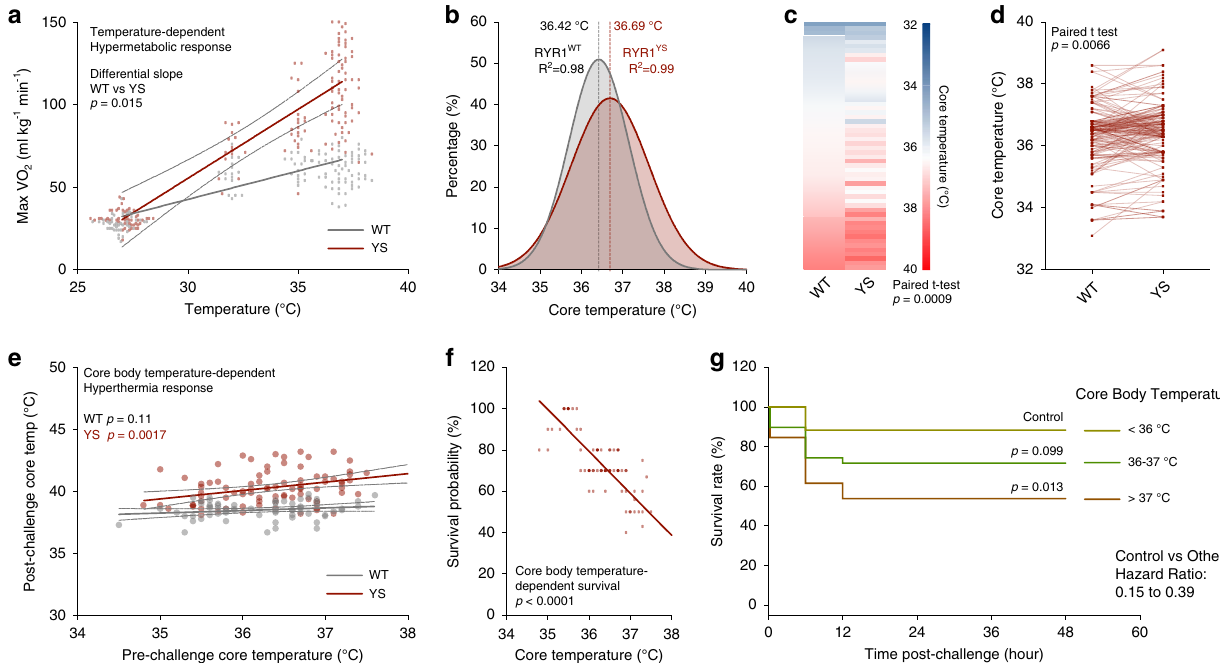
Fig. 2 Enhanced heat sensitivity and elevated core body temperature in Y524S mice. a Maximum oxygen consumption rate (maxVO 2 ) of WT ( n = 92) and YS ( n = 115) mice during heat challenge at the indicated temperatures. b Distribution of baseline core body temperature of WT ( n = 175) and YS ( n = 202) mice at room temperature. c , d Comparison of baseline core body temperatures of WT and YS mice in littermate pairs analyzed per litter ( c n = 56 pairs) and per individual animals ( d n = 177 pairs). e Relationship of baseline core body temperature and hyperthermia response after acute 37 °C heat challenge in WT ( n = 66) and YS ( n = 85) mice. f Effect of baseline core body temperature on the estimated survival probability of YS mice ( n = 85) after acute heat challenge. g Kaplan – Meier analysis of the heat challenge survival rate of YS mice ( n = 85) grouped by baseline core body temperature. All mice were housed at room ambient temperature (20.2 ± 0.4 °C) prior to heat challenge. All mice were within the controlled age range (8.9 ± 0.9 week old) at the time of study. P values are indicated as analyzed by F -test for differential slope of linear regressions ( a ), paired t test ( c , d ), F -test for deviation from zero-slope of linear regression ( e , f ), and Mantel – Cox log-rank test ( g ). All statistical tests are two-sided. R 2 values are indicated to quantify goodness-of- fi t to Gaussian distribution ( b ). Survival probability of each mouse is estimated based on the survival rate from ten mice in the respective core body temperature ( f ) subgroups. Data are represented as asymmetrical 95% con fi dence intervals (CI) from linear best- fi t line ( a , e ). Source data are provided as a source data fi